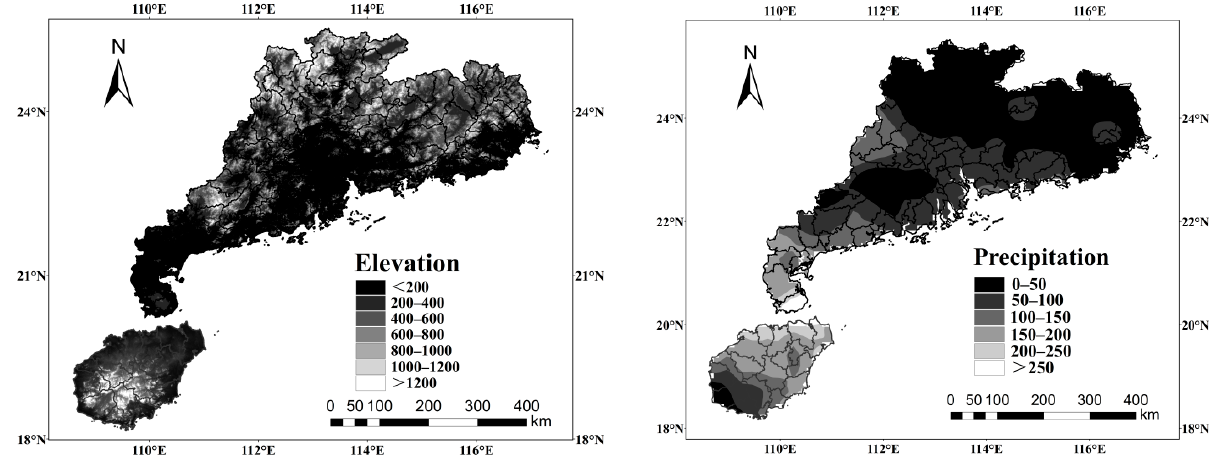
Figure 4. The digital elevation model (DEM) (m; Left ) and cumulative precipitation during 14–19 July 2014 (mm; Right ).